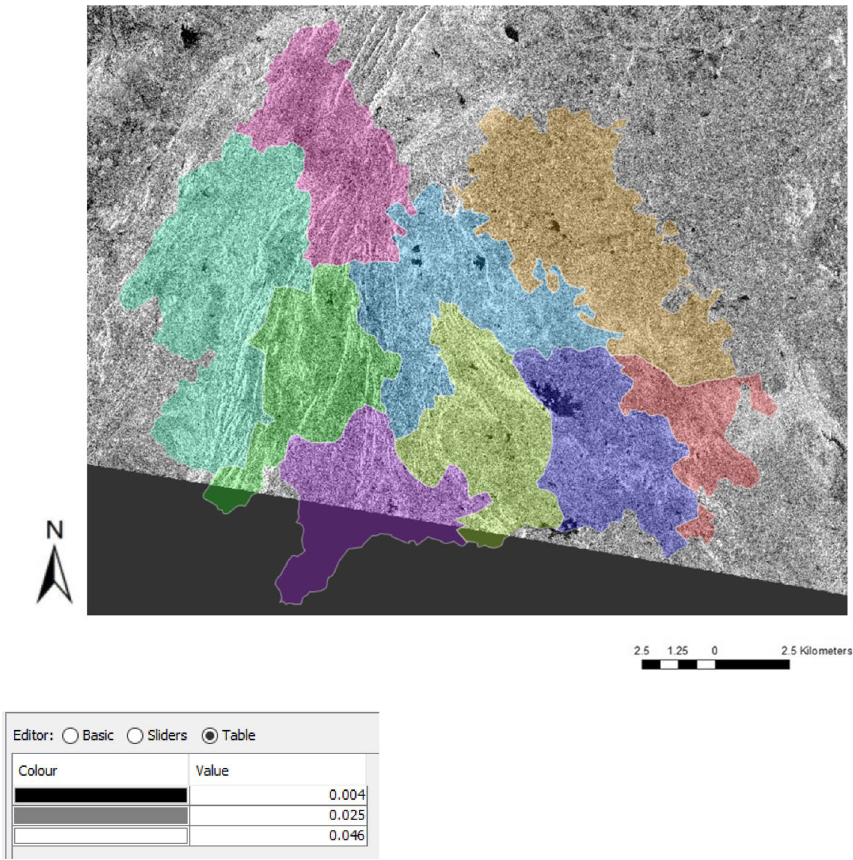
Fig. 9 Sentinel-1A-GRD terrain corrected image of the Udaipur